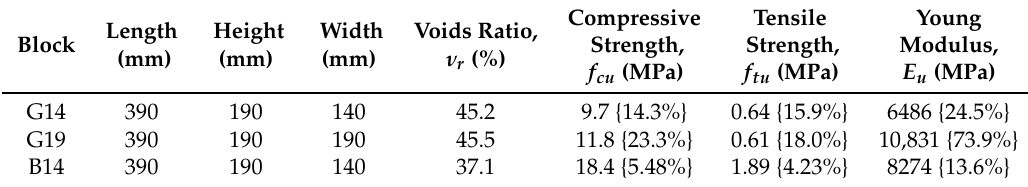
Table 2. Mechanical properties of hollow concrete blocks.